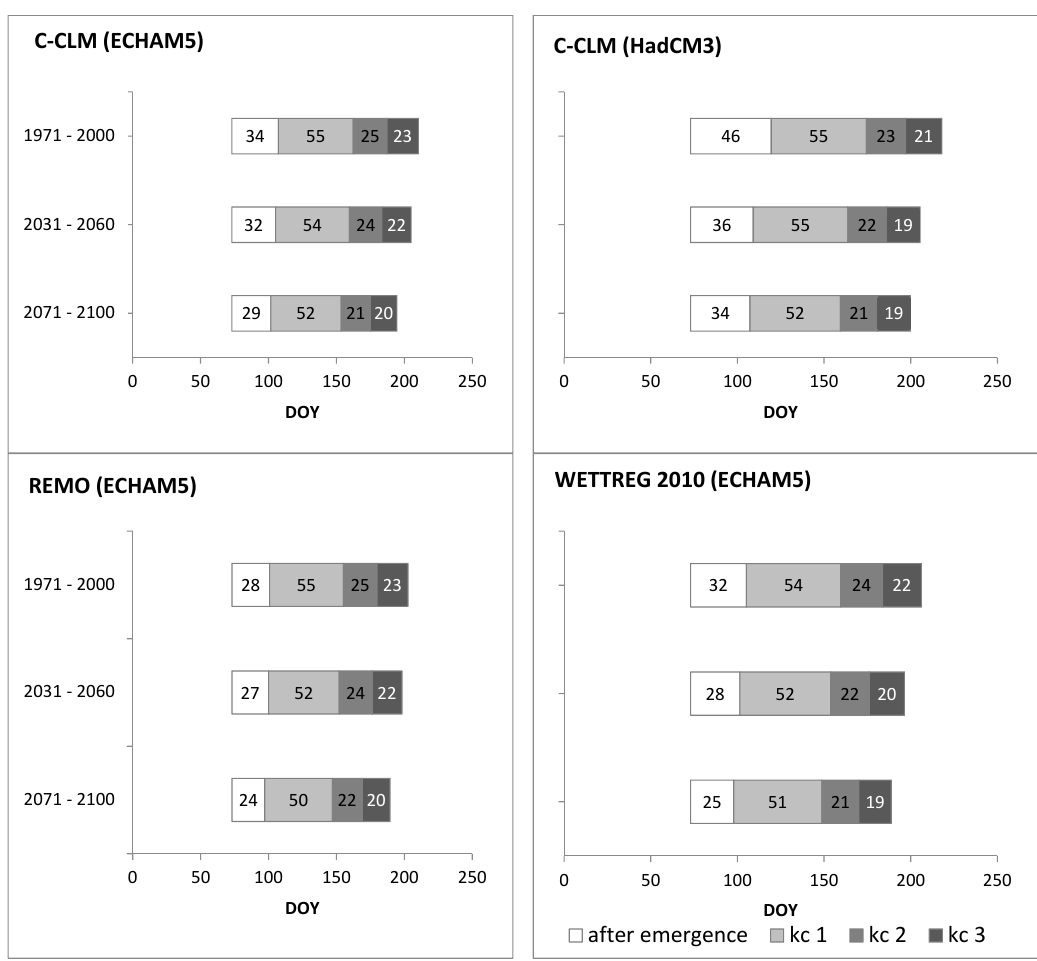
Figure 3. Predicted duration of cultivation period and length of single growing stage of onion in days in the 30-year periods 1971–2000, 2031–2060 and 2071–2100 for all used climate model combinations, calculated in days of year.